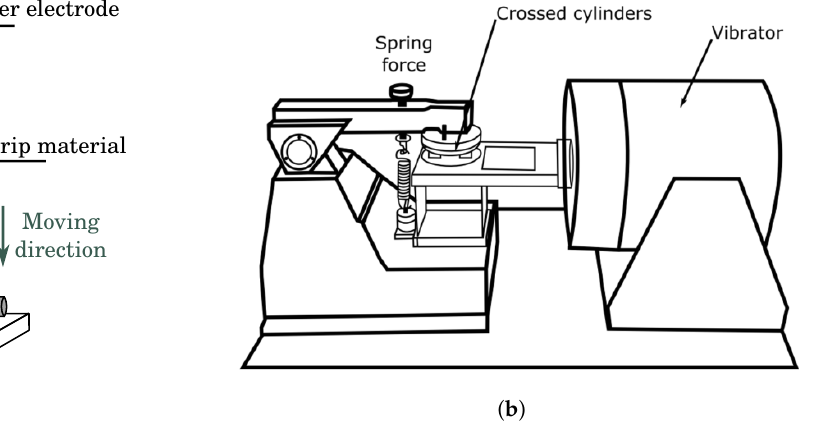
Figure 6. ( a ) Outline from an article by Wu G. et al. [44] of arc generator. ( b ) Outline of the experi- mental setup from an article by Granding M. [6]. Copyright (2023), with permission from